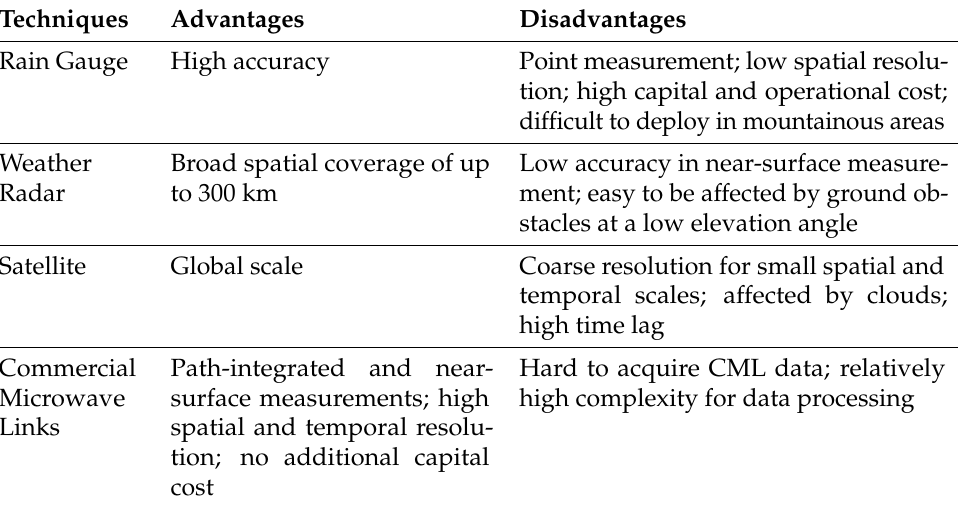
Table 1. Comparisons of conventional and CML-based rainfall measurement techniques.